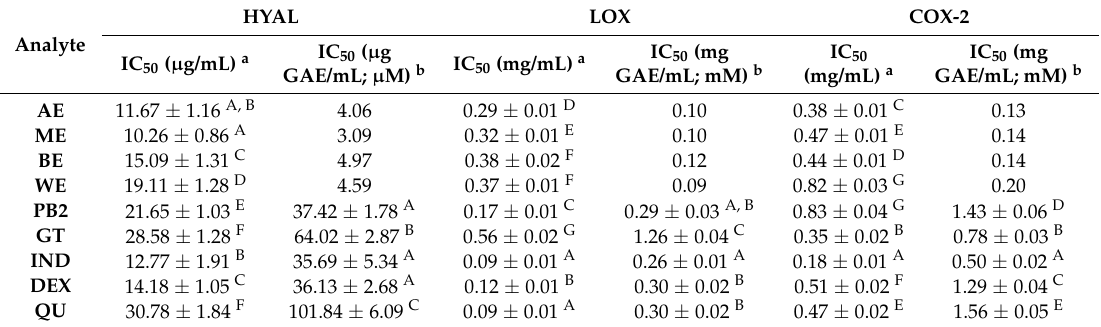
Table 2. Anti-inflammatory activity of G. procumbens stem dry extracts in non-cellular models.